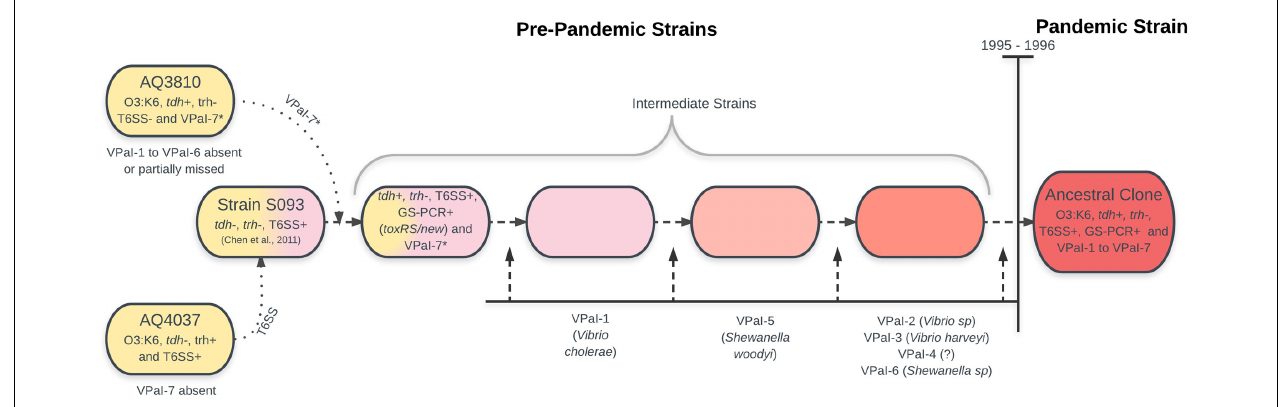
FIGURE 1 | Schematic representation of a plausible origin of the pandemic V. parahaemolyticus clone founder bacteria. Ancestral bacteria on the left, intermediates from left to right. According to the text and references